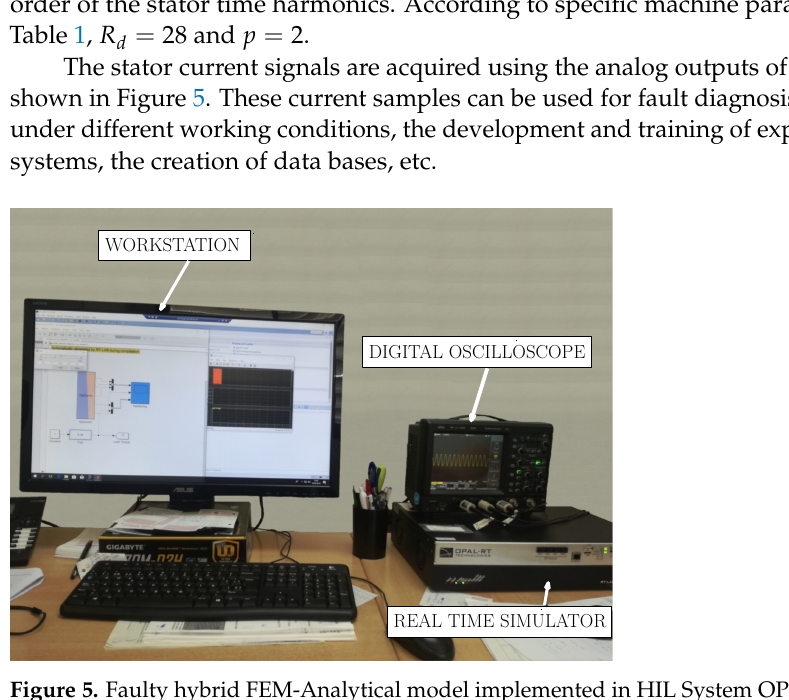
Figure 5. Faulty hybrid FEM-Analytical model implemented in HIL System OP4500. Stator currents are acquired using a digital oscilloscope properly connected to the HIL. HIL characteristics are found in Appendix